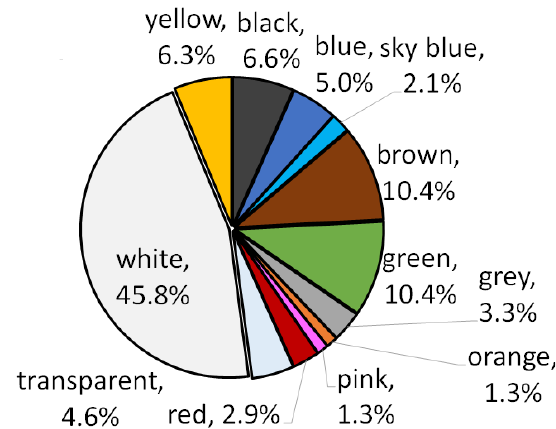
Figure 2. Color of the collected debris.